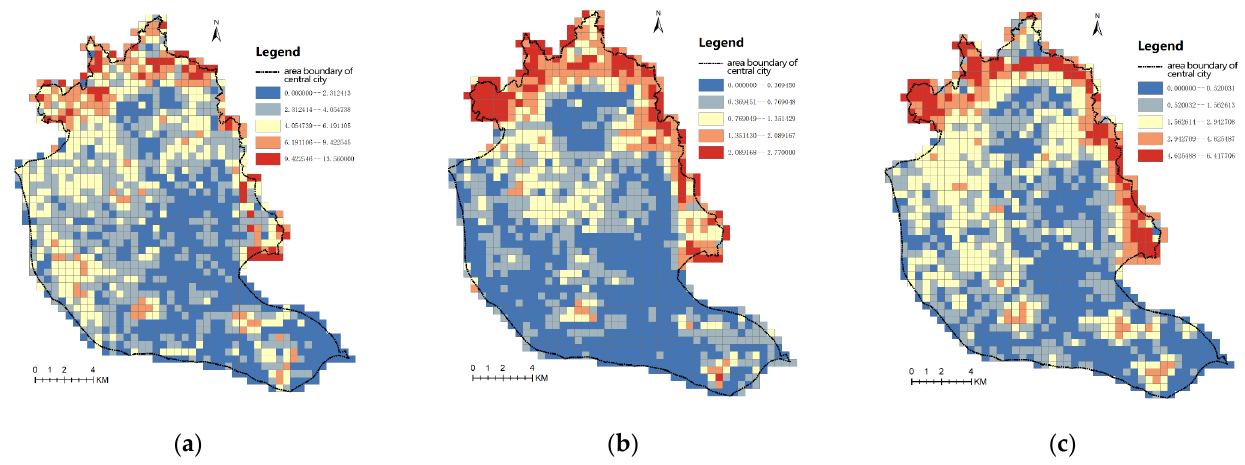
Figure 6. Map of LPI change in the central area of Fuzhou City: ( a ) landscape patch index of 2000; ( b ) landscape patch index of 2010; ( c ) landscape patch index of 2021. Red is the high LPI value, blue is the low LPI value. Table 6. LSI values of green spaces in central Fuzhou during the period 2000, 2010,